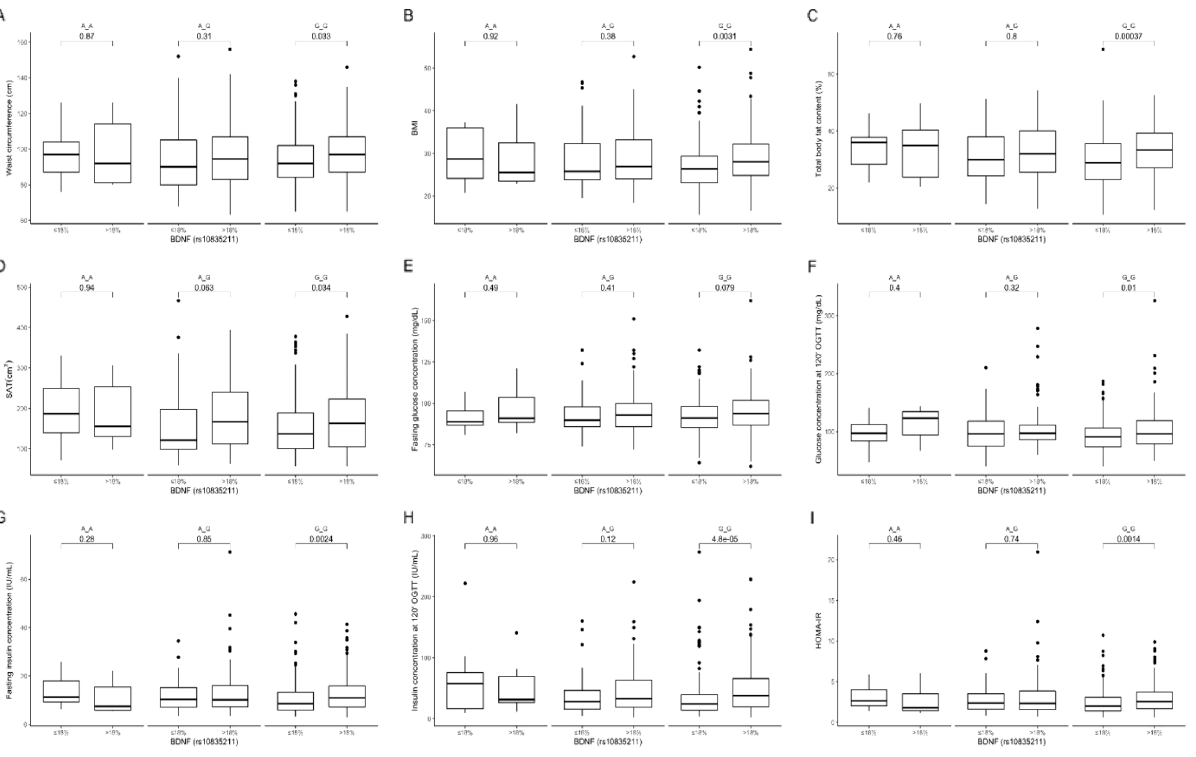
Figure 3. The ( A ) waist circumference (cm); ( B ) BMI (kg/m2); ( C ) total body fat content (%); ( D ) SAT (cm3); ( E ) fasting glucose concentration (mg/dl); ( F ) glucose concentration (mg/dl) at 120’ OGTT; ( G ) fasting insulin concentration (IU/mL); ( H ) insulin concentration at 120’ on the OGTT; and ( I ) HOMA-IR in BDNF rs10835211 genotype carriers stratified by daily protein intake (≤ 18% and > 18% of the total daily energy intake).